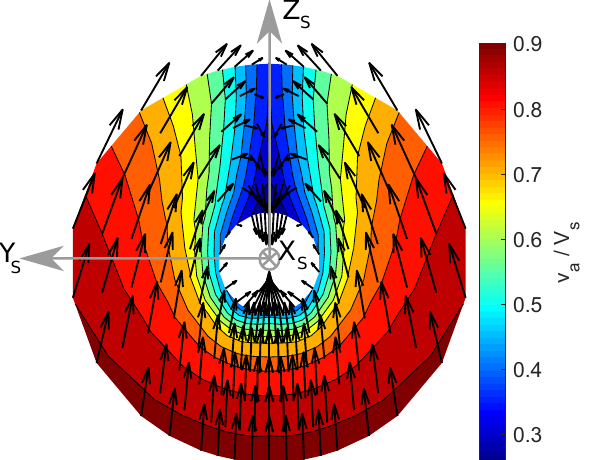
Figure 1. Wake field for a single screw ship. Reproduced from [1] with permission from the authors.